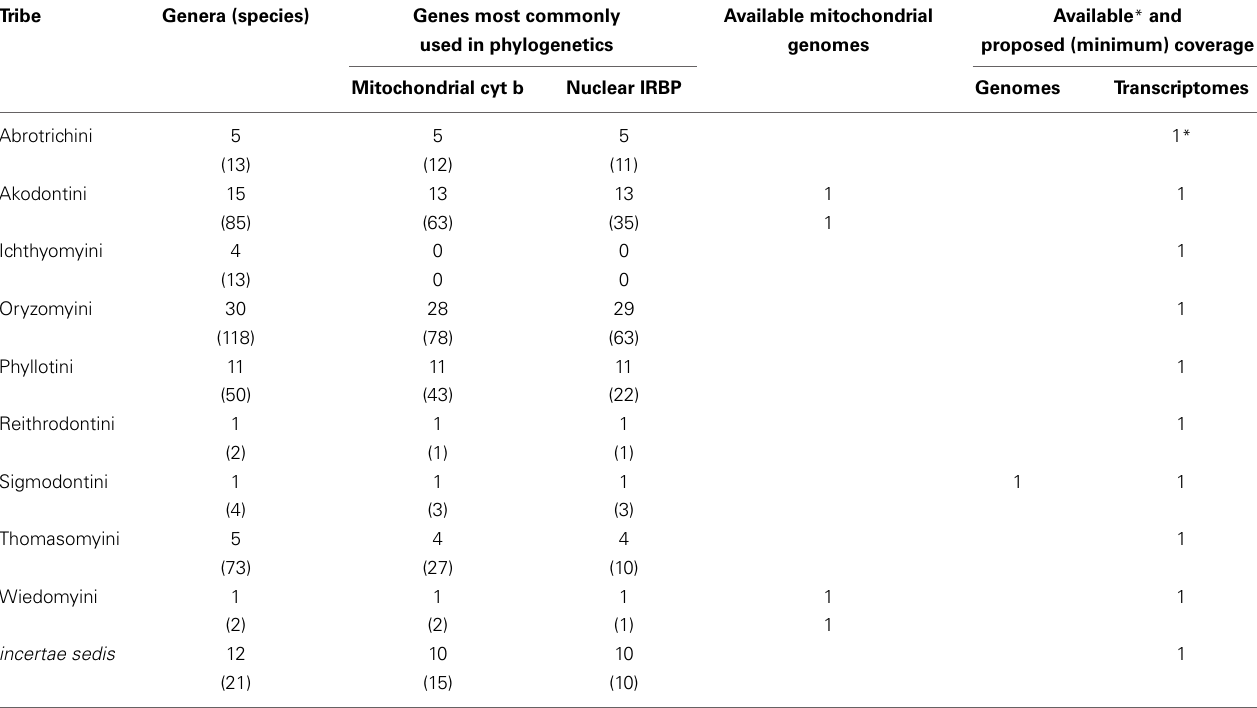
Table 2 | Classification and diversity (number of species and genera per tribe) of Sigmodontinae in South America (following Patton et al., in press), with a survey of the available taxonomic coverage for the two most commonly used loci in sigmodontine phylogenetic studies, and available and proposed genomic and transcriptomic